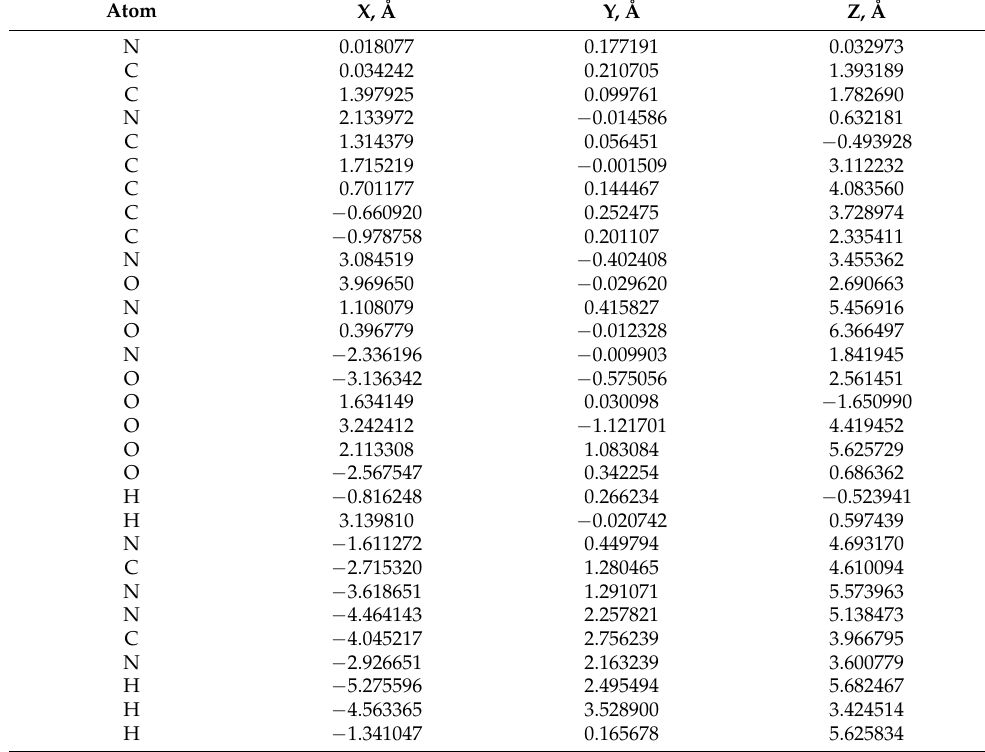
Table A4. Convergent geometries of E-IV.